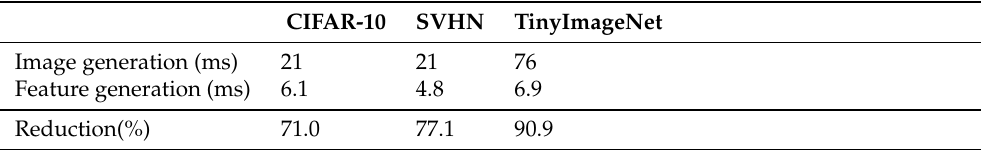
Table 6. Runtime of the generative model’s training on one batch in milliseconds, including running both the generative and discriminative models, calculating the loss value, and using a training step. The third row shows the ratio of the runtimes of the two methods. CIFAR-10 SVHN TinyImageNet Image generation (ms) 21 21 76